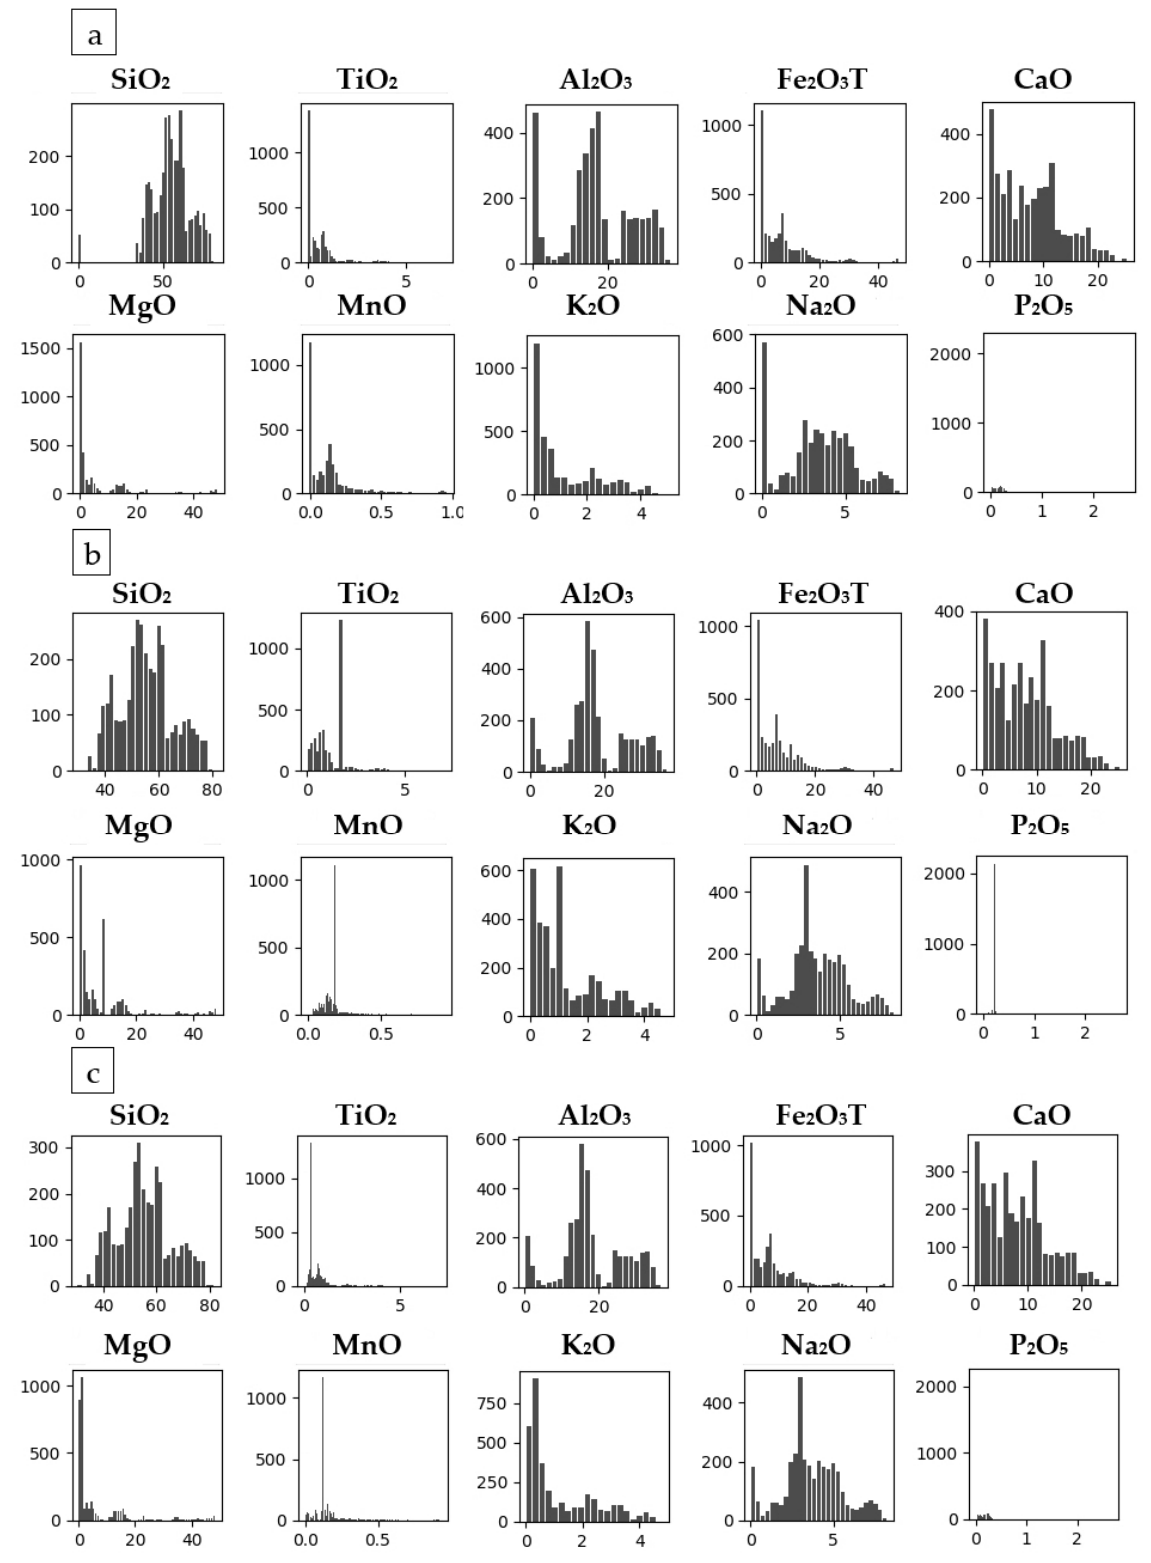
Figure 8. Histograms of the datasets after outlier removal: (a ) Dataset 4, ( b ) Dataset 5, and ( c ) Dataset 6.